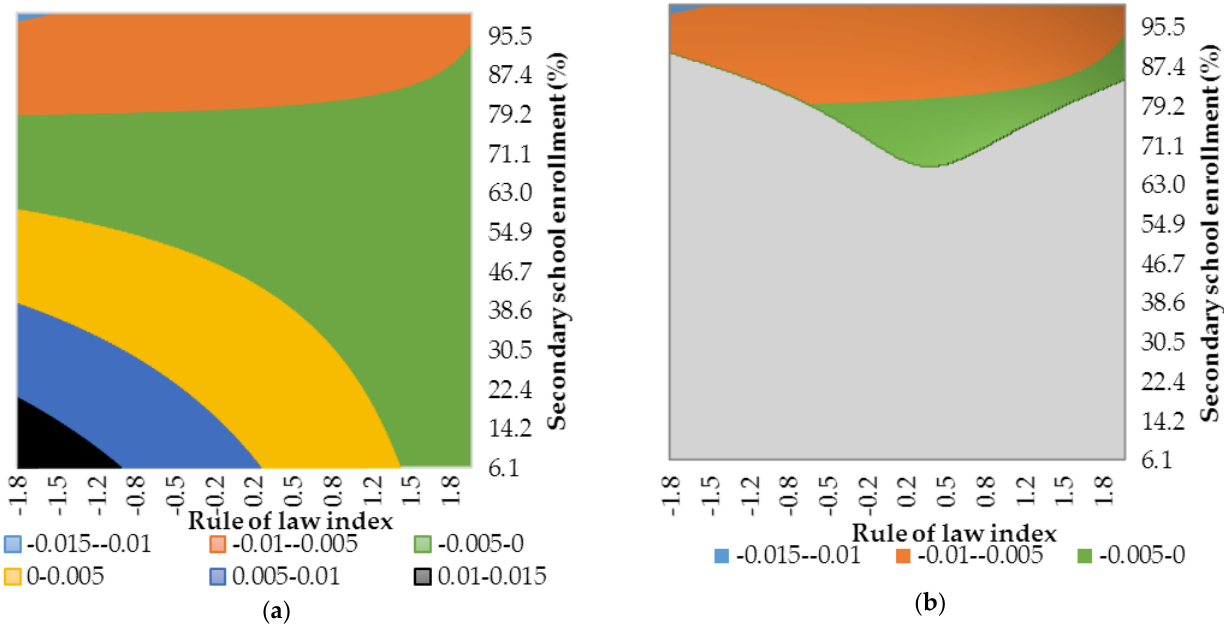
Figure A5. Conditional effect of financialisation on growth based on Est. 5 in Table A2. ( a ) Estimated conditional slope coefficient over the whole range of observed values for institutional quality and development level. ( b ) Estimated statistically significant conditional slope coefficient. Gray represents a combination of institutional quality and development level for which effect of financialisation on growth is statistically insignificant. Source: authors’ contributions.